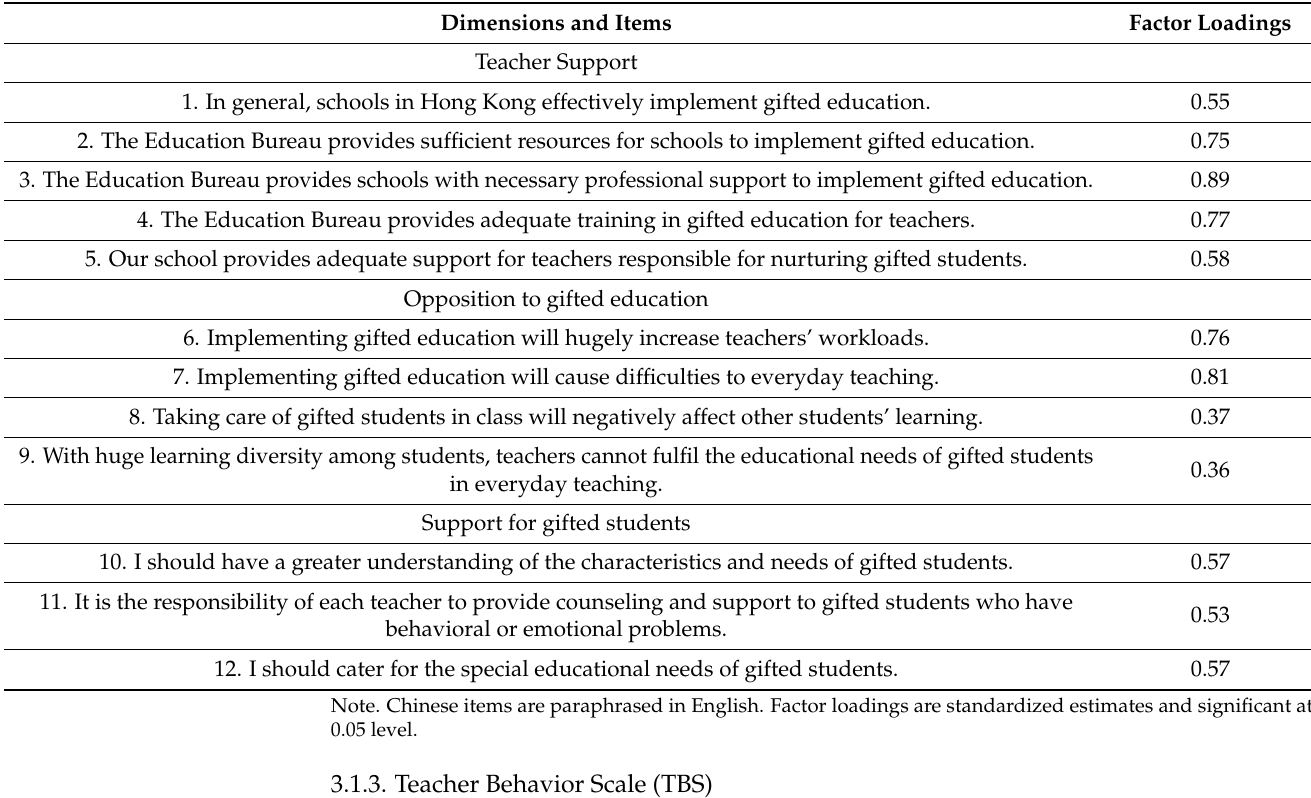
Table 4. Factor loadings of the12 items of the Teacher Attitude Scale at pretest of the matched sample. Dimensions and Items Factor